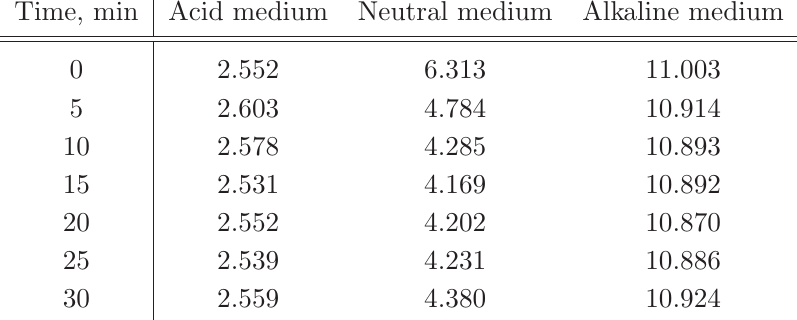
Table 1 pH variation in photooxidation